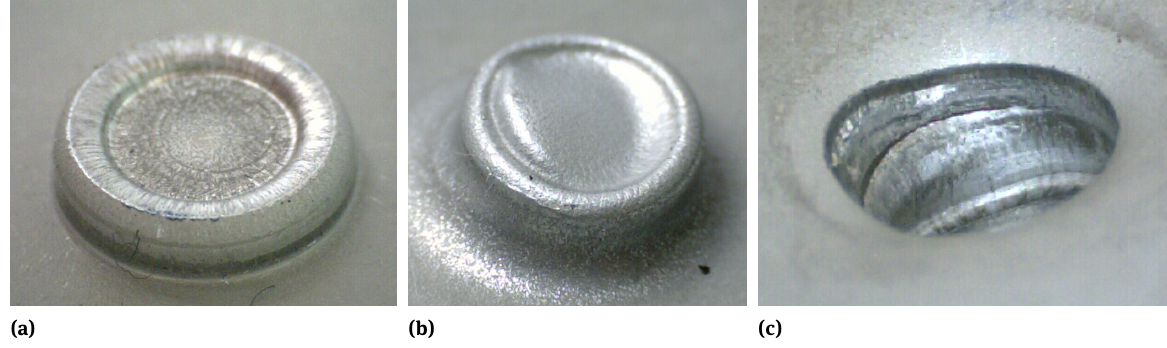
ues were measured in joints with H220PD steel sheets (av- erage value of shearing force F s = 3635 N) and significantly measured in clinched joints with DX53 steel sheet